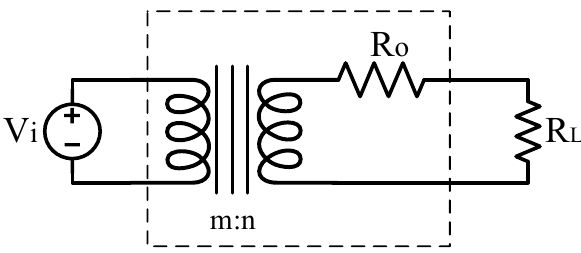
Figure 17. Simplified model used in the analysis of SC converters.